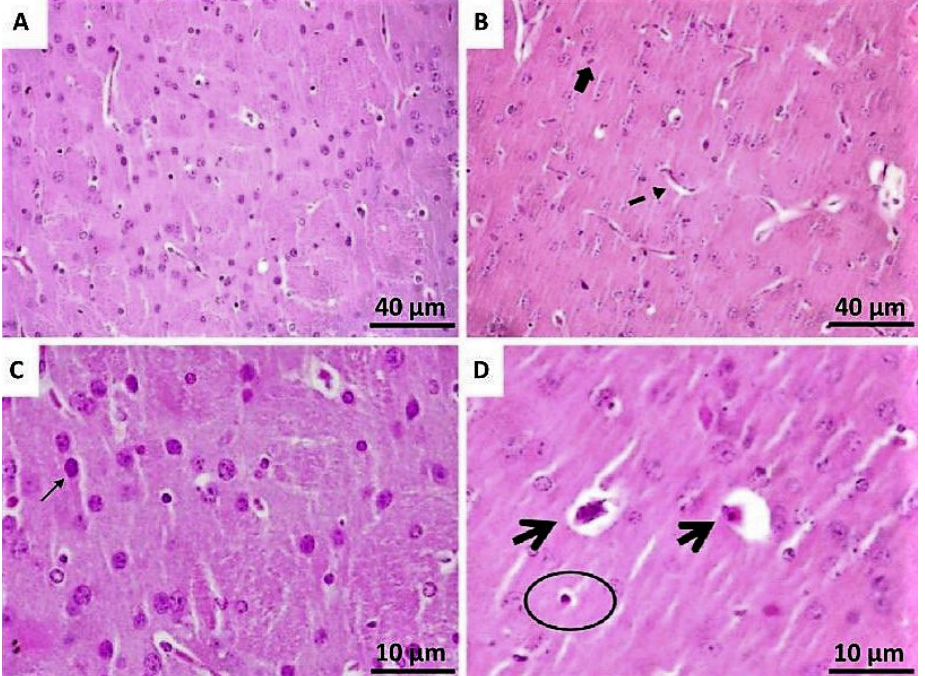
Figure 3. Representative photomicrographs of histological sections stained with Hematoxylin-eosin (HE) showing brain tissue in the striatum—CPu. ( A ) and ( C ) represent the intact side (con- trols) with intense cellularity, mainly neuronal (fine arrow), and the images ( B ) and ( D ) represent the lesioned side. In ( B ), there was an increase in both vascularization (dashed arrow) and pres- ence of microglia (arrow completed). In ( D ), it was observed pyknosis (continuous arrows) and intense nuclear pyknoses accompanied by cytoplasmic retraction, with consequent pericellular halo formation (circle). Magnification of 100× ( A , C ) and 400× ( C , D ). In addition, cells exhibiting increased cytoplasmic acidophilia, contraction of chro- matin, increased density and progressive dissolution of chromatin, with dye affinity loss were identified in the same tested group. There was also intense nuclear pyknoses accom- panied by cytoplasmic retraction, with consequent formation of pericellular halo and the intense presence of fibrous astrocytes. In the 6-OHDA/BV 0.01 mg·Kg −1 -treated group, an increase in cellularity (astrocytes, mainly) and reduction in vascularization were observed, along with a remaining presence of necrotic cells and fibrous astrocytes (Figure 4). The presence of necrotic neurons in some areas was also visualized in the 6-OHDA/BV 0.05 mg·Kg −1 -treated group, which also pre- sented increased vascularization. The group treated with 6-OHDA/BV 0.1 mg·Kg −1 pre- sented increased cellularity and minor vascularization.